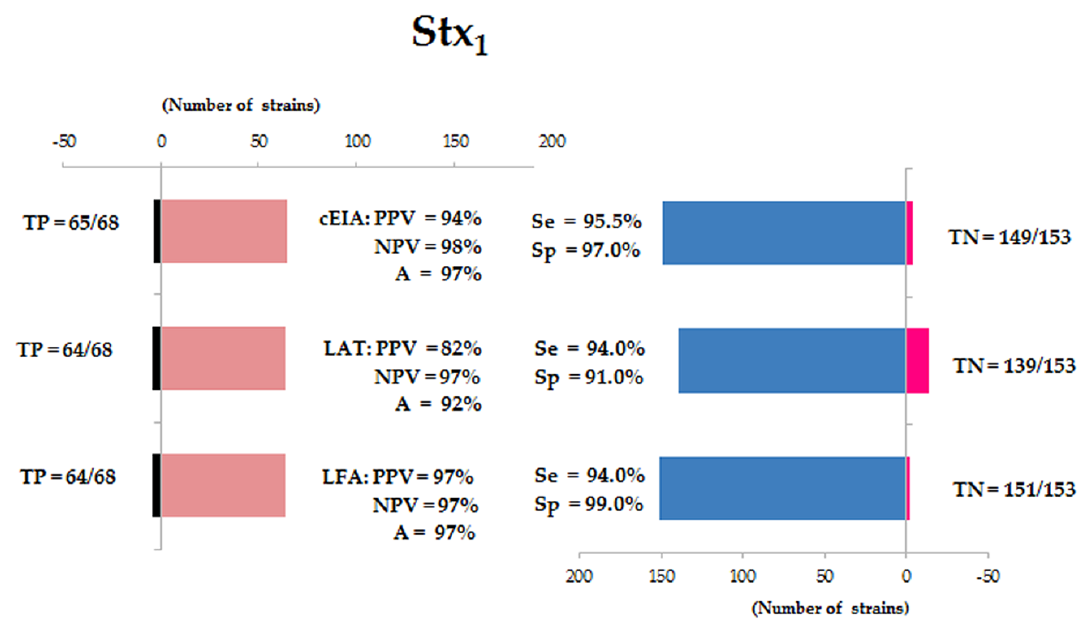
Figure 1. Analysis of Stx 1 detection by capture ELISA (cEIA), latex agglutination test (LAT) and the lateral flow assay (LFA). TP = true positive strains; TN = true negative strains; PPV = positive predictive value; NPV = negative predictive value; A = accuracy; Se = sensitivity and Sp = specificity.